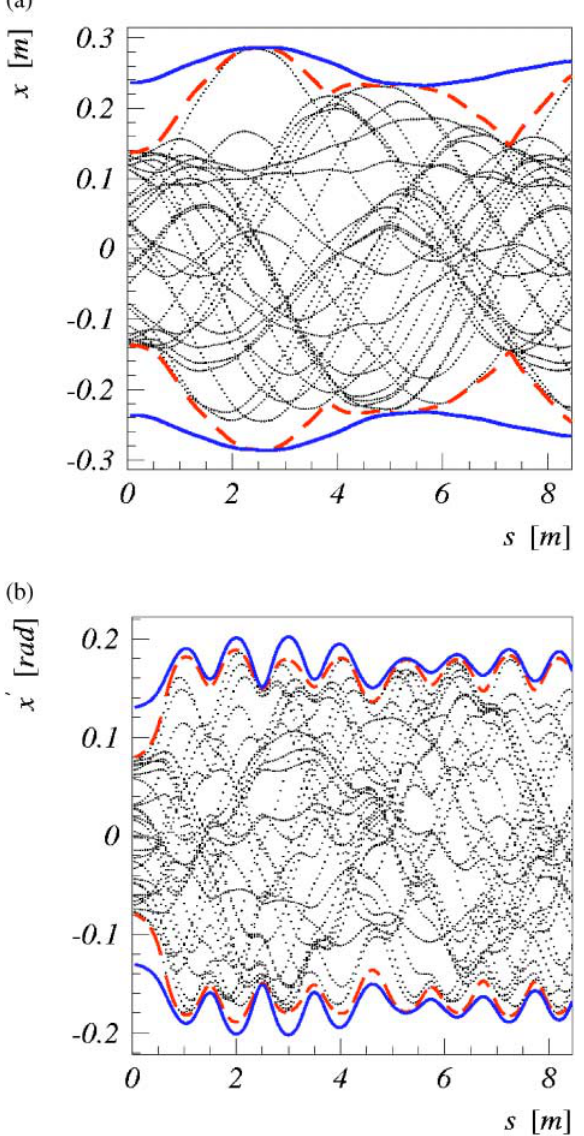
FIG. 1. (Color) (a) r max (solid line), theoretical envelope X (dashed line), and 30 particle trajectories (dotted lines). (b) x 0 vs s (dotted lines), X 0 (dashed line), and line) obtained for j